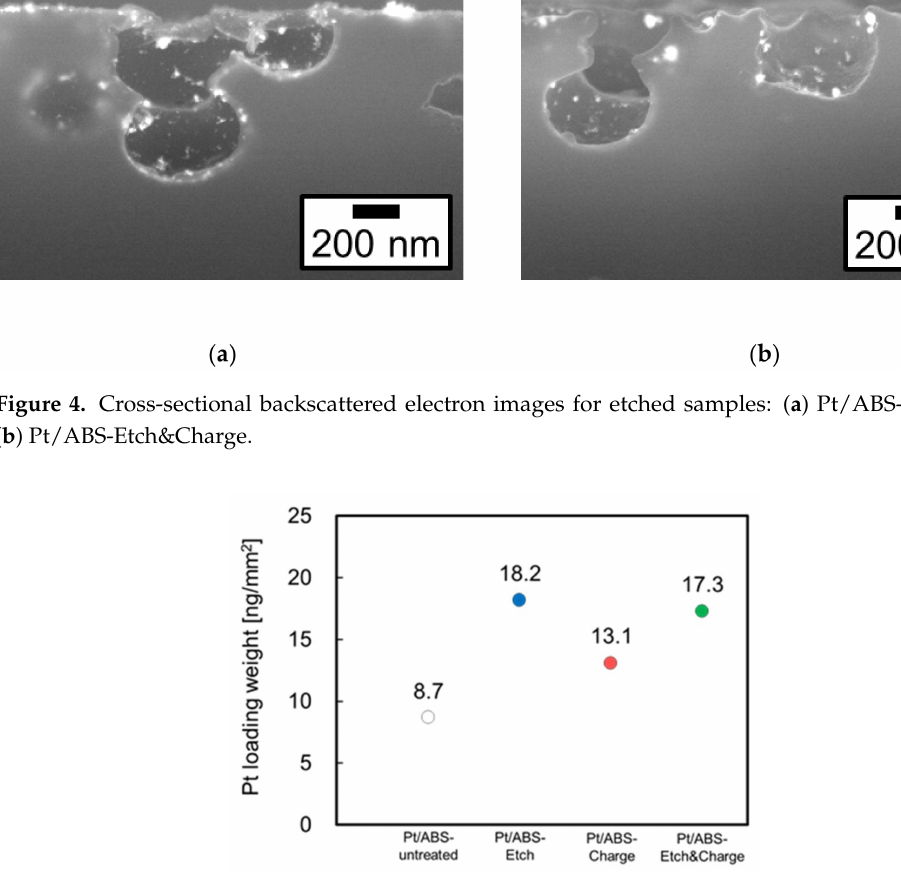
Figure 5. Pt loading weights of four types of Pt/ABS samples prepared using an electron-beam irradiation reduction method (EBIRM): Pt/ABS-untreated, Pt/ABS-Etch, Pt/ABS-Charge, and